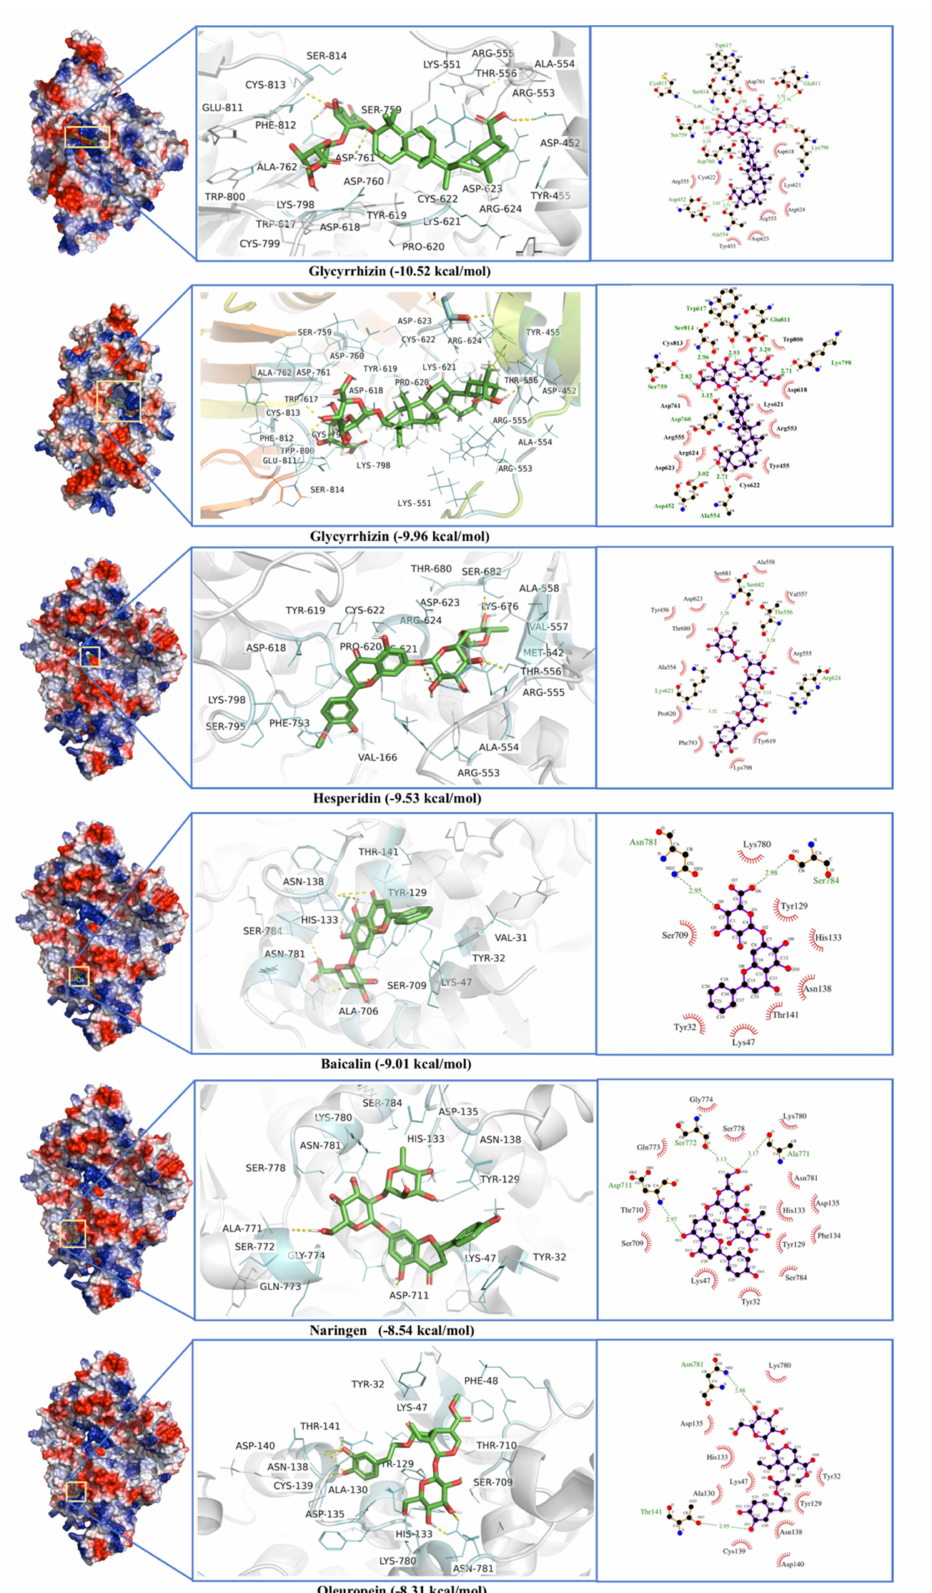
Figure 6. Glycyrrhizin, Hesperidin, Baicalin, Naringen, and Oleuropein docking against SARS-CoV-2 RNA-dependent RNA polymerase